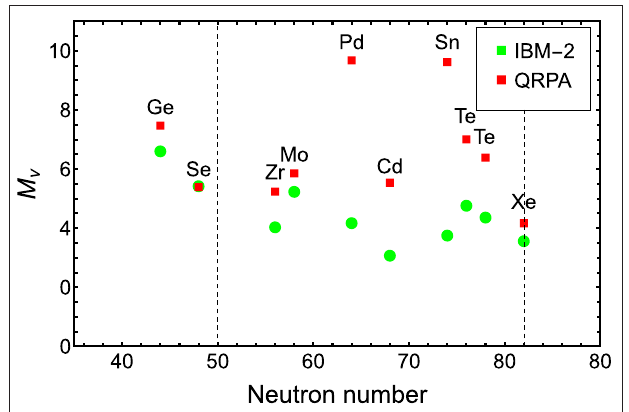
FIGURE 1 | Total light neutrino exchange 0 νββ nuclear matrix elements M ν obtained with interacting boson model (IBM-2) and quasiparticle random phase approximation (QRPA) using same form factor charges, same overall sign for tensor matrix elements, and the convention that M ν > 0.